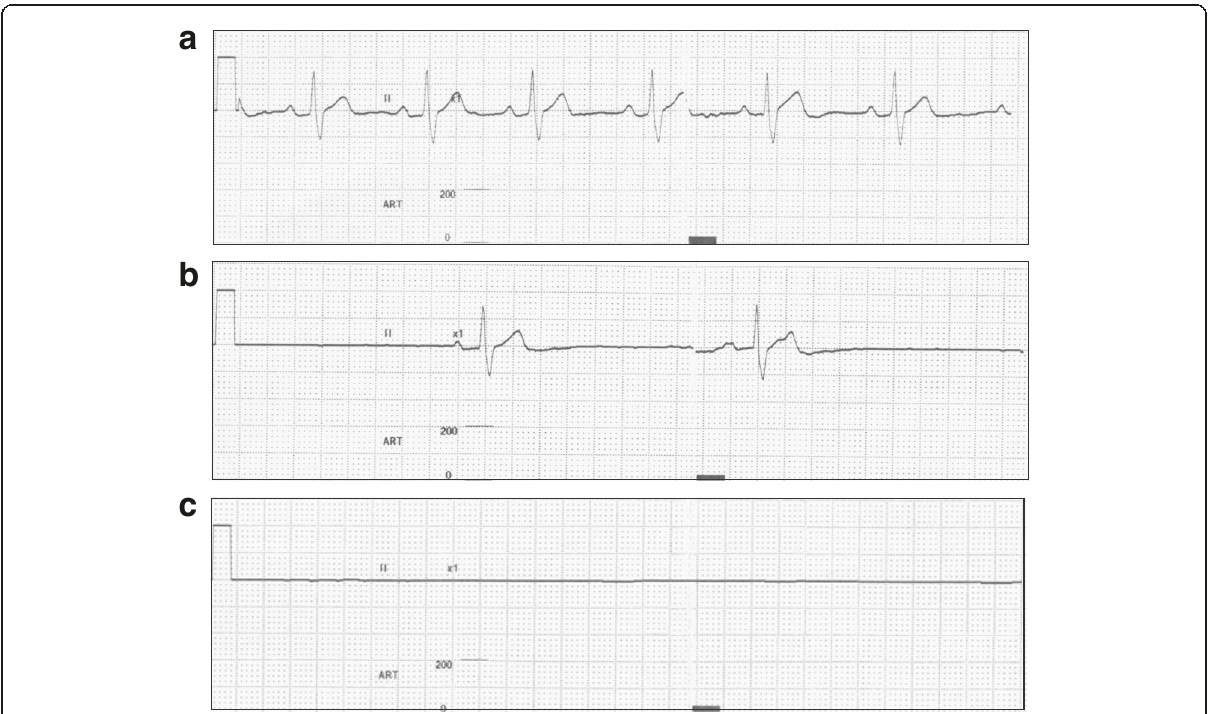
Fig. 3 Electrocardiographic changes before CPR. a Initial electrocardiogram: HR=75 bpm. b Approximately one minute and few seconds after induction: HR=20 bpm. c Just before cardiopulmonary resuscitation: HR=0 bpm